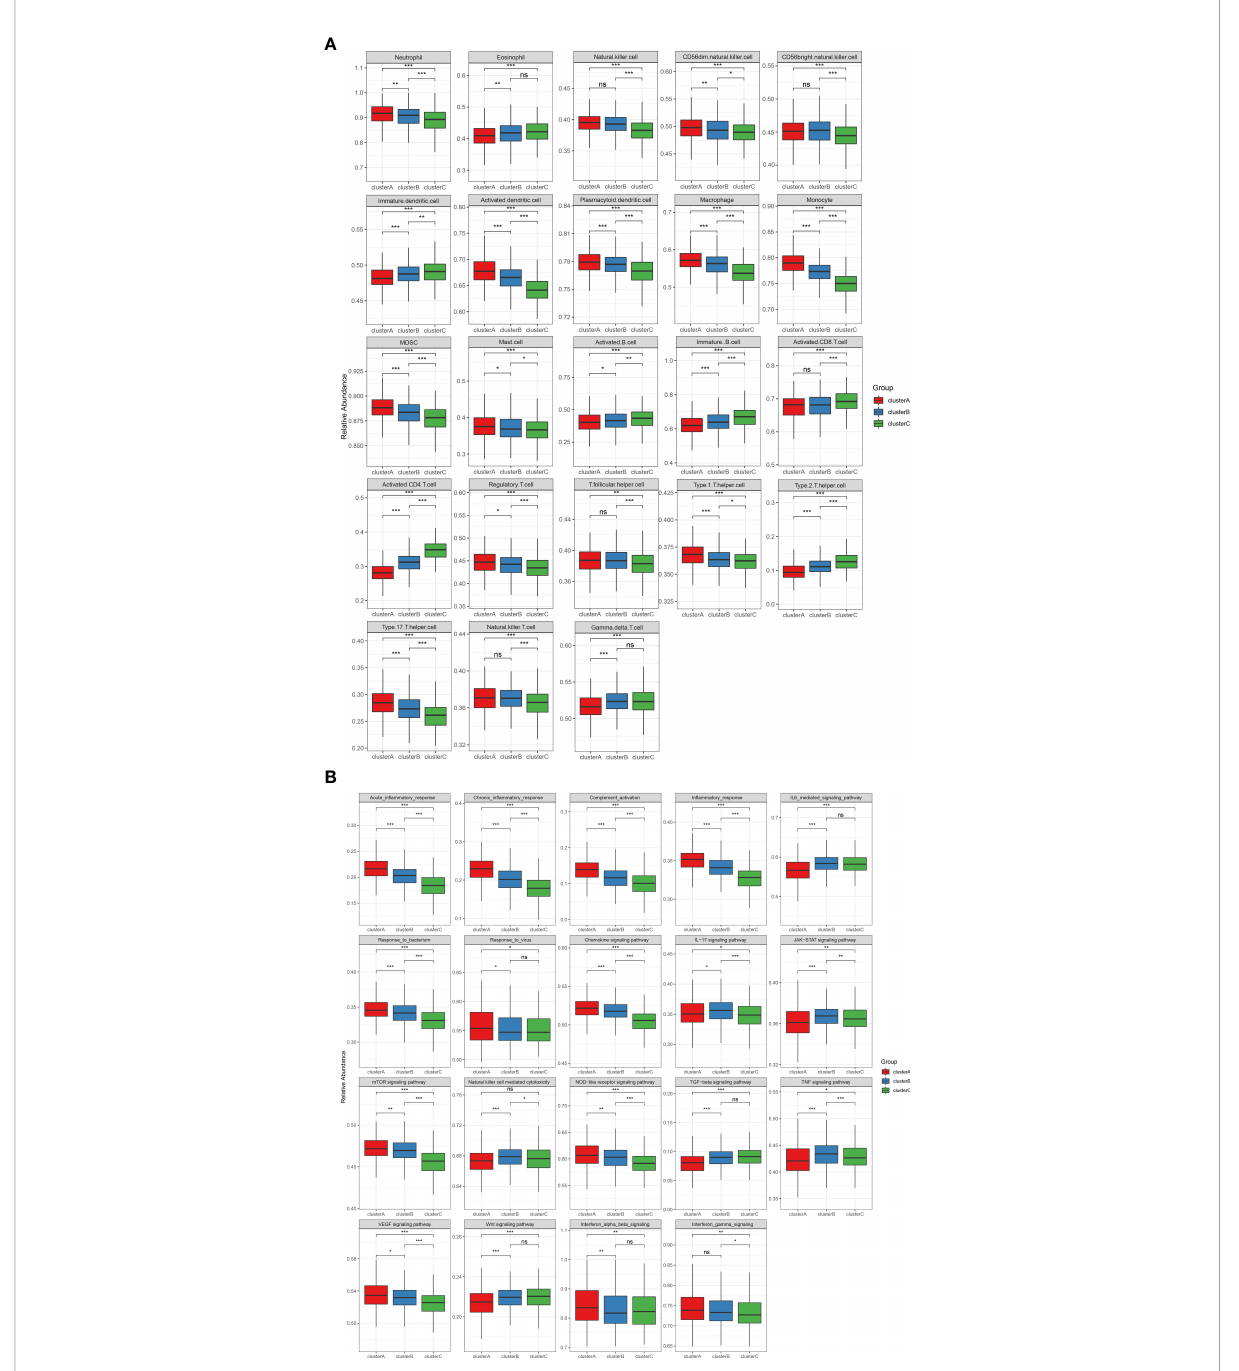
FIGURE 3 (A) The abundance of in fi ltrating immunocytes cells in the three m6A clusters. The upper and lower ends of the boxes represent the interquartile range of values. The lines in the boxes represent the median value, and the black dots show the outliers. The asterisks represent the statistical p-value (*P < 0.05, **P < 0.01, ***P < 0.001), ns P>=0.05. (B) Some rheumatoid arthritis-related immune reaction gene sets showed the activity differences in the three m6A clusters (*P < 0.05, **P < 0.01, ***P < 0.001), ns